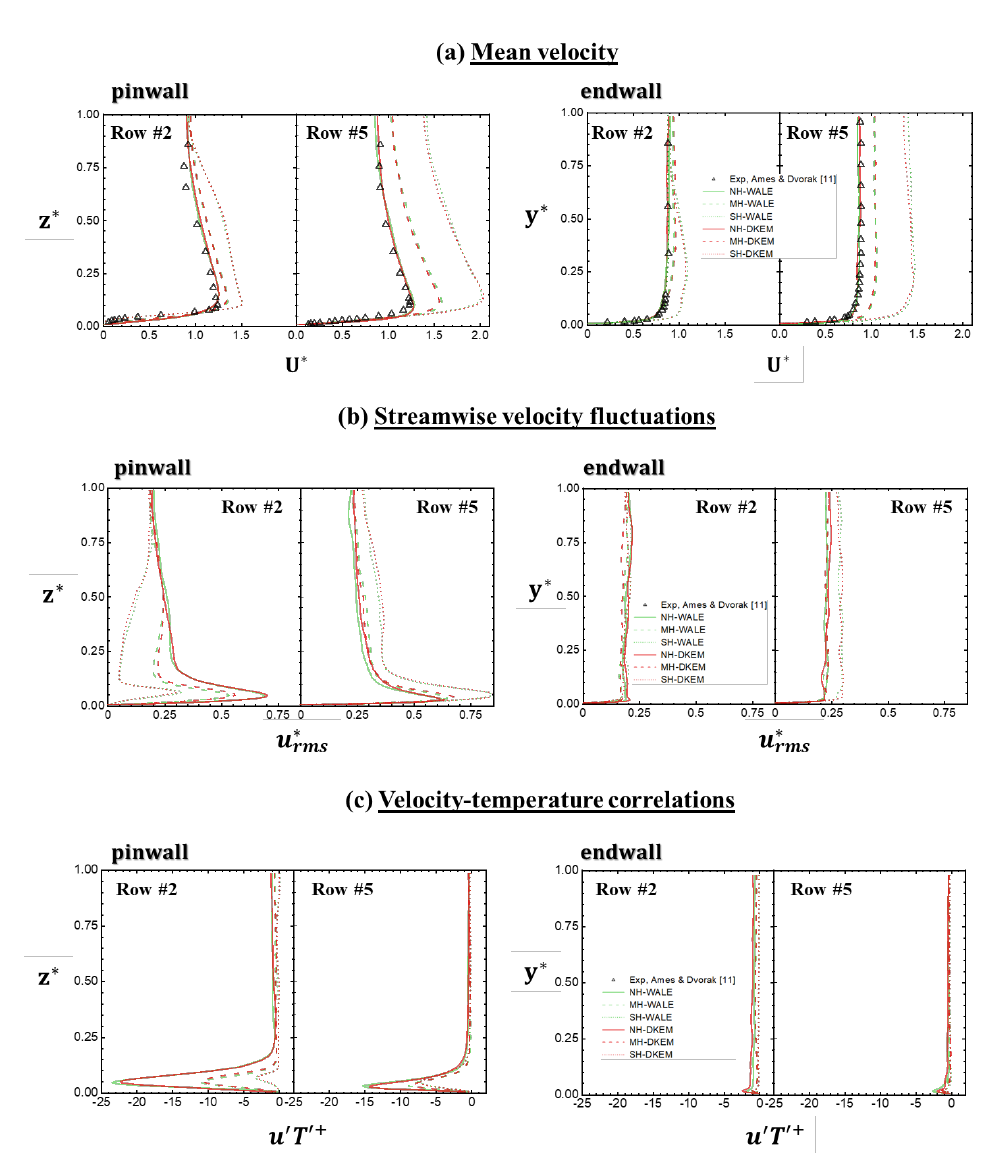
Figure 10. ( a ) Mean velocity, ( b ) streamwise velocity fluctuations, and ( c ) velocity-temperature correlations obtained by DKEM and WALE SGS models. Open circle is experimental data obtained under negligible heating.